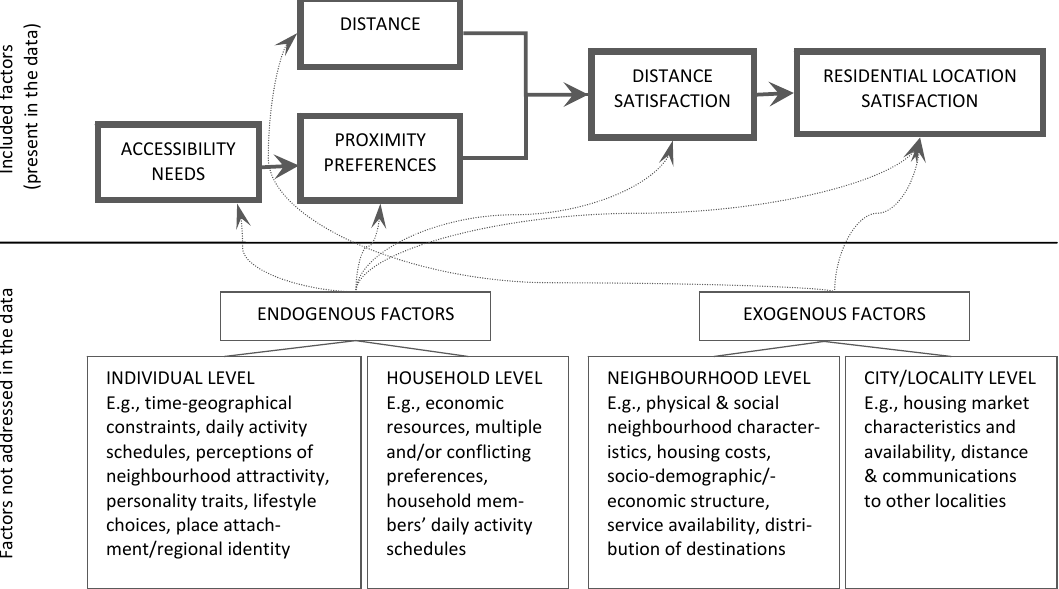
Figure 4. Tentative theoretical model of suggested relationships between residential location satisfaction, distance satisfaction, distance and proximity preferences, and possible factors that are not present in the survey